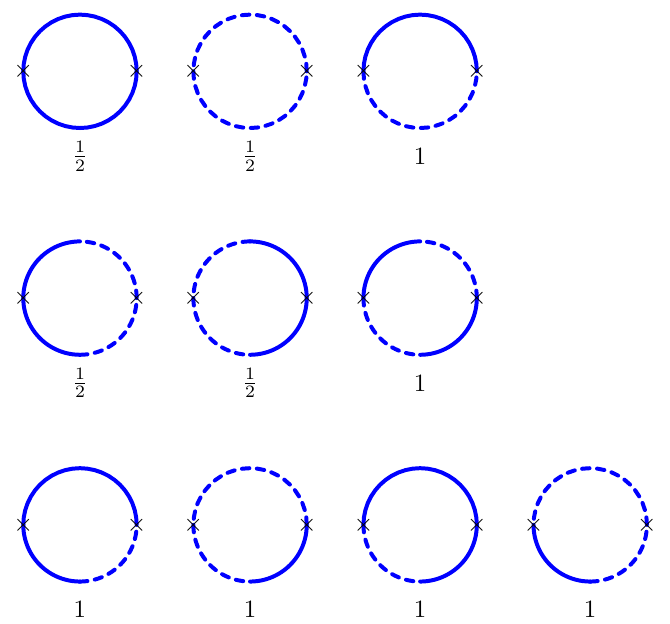
Figure 28. Symmetry factors for all the ten one loop integrals.